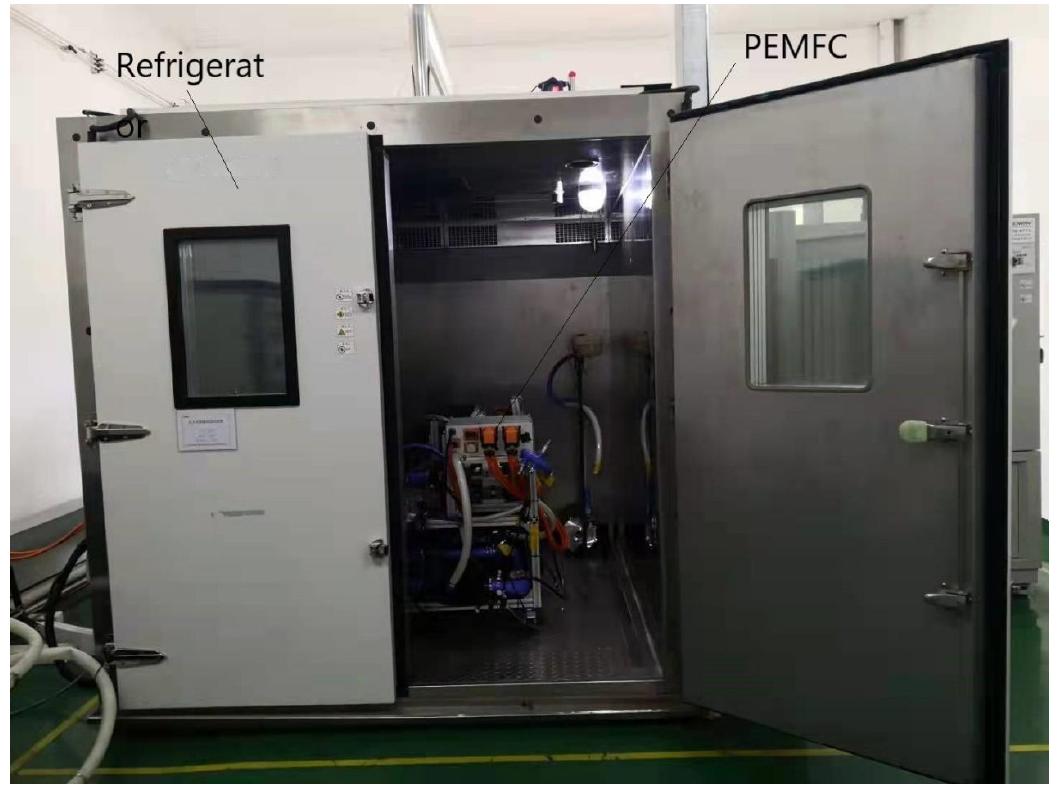
Figure 1. The test bench for the experiment.